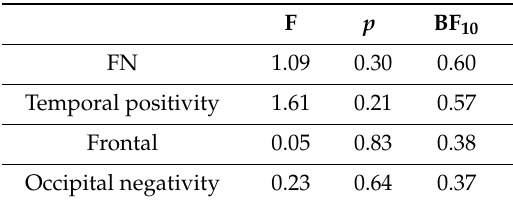
Table 4. F-ratio, p -values, and the Bayes 10 (BF 10 ) factor for the main e ff ect of age group in the comparison of “correct” feedback